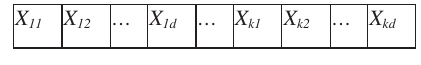
Figure 2: Representation of a